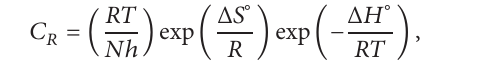
Table 3: Activation parameters 𝐾 and Δ𝐺 ∘ dissolution in 1N H variously substituted piperidin-4-ones at optimum concentration (0.4 × 10 − 3